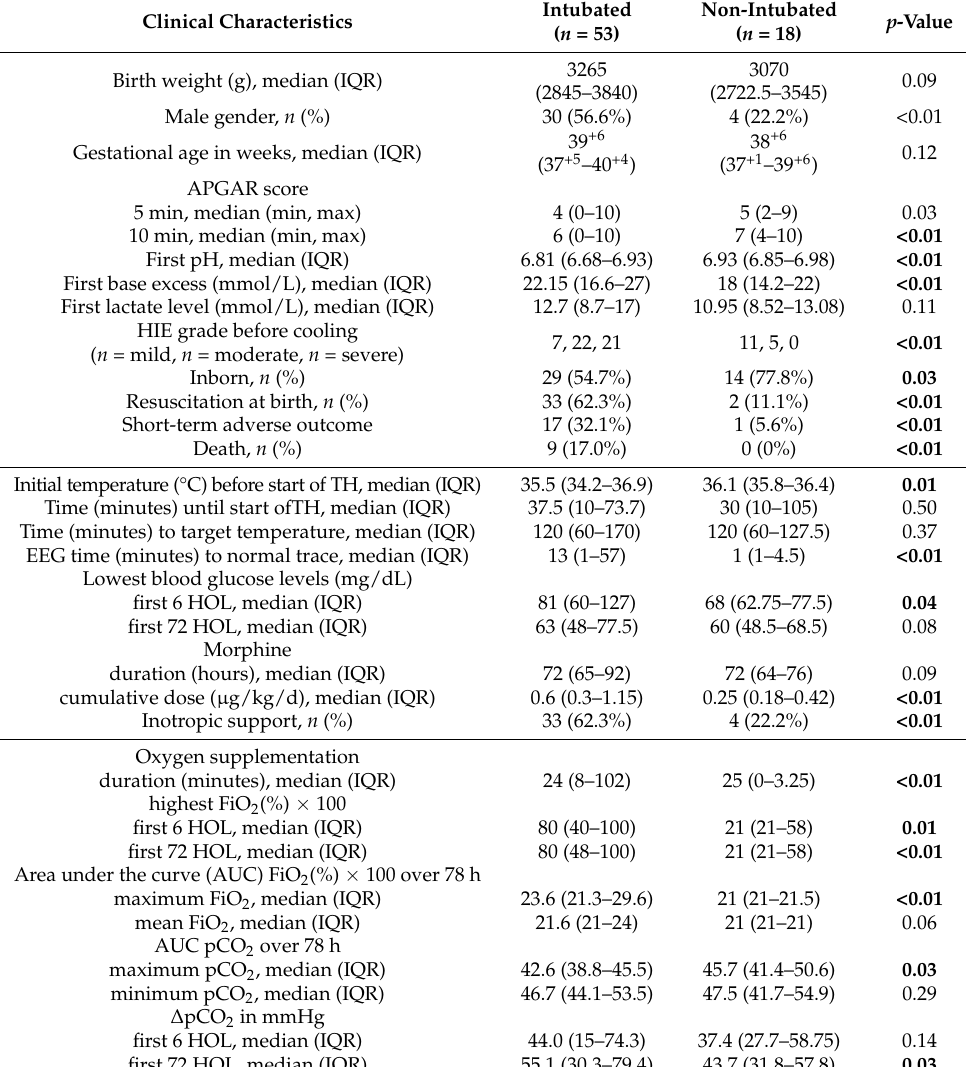
Table 1. Descriptive data of the analyzed cohort according to ventilation status (mechanically ventilated or not) before the start of therapeutic hypothermia (TH). Data are presented as median and interquartile range